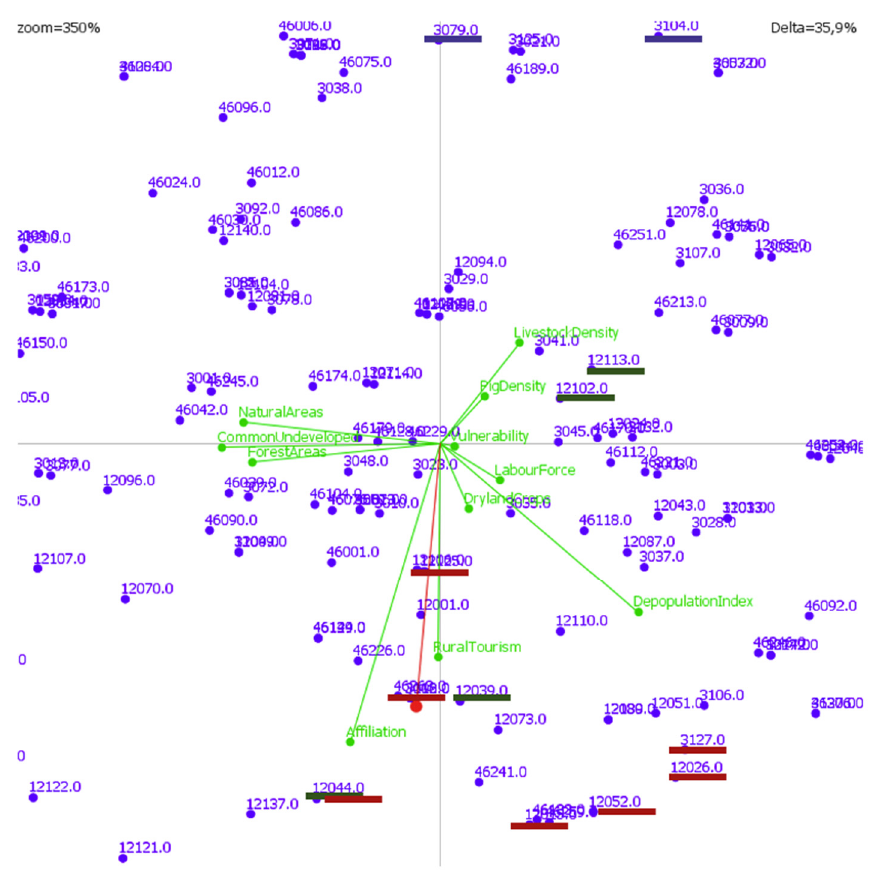
Figure 14. GAIA plane for municipalities with sustainable areas for pig farms.